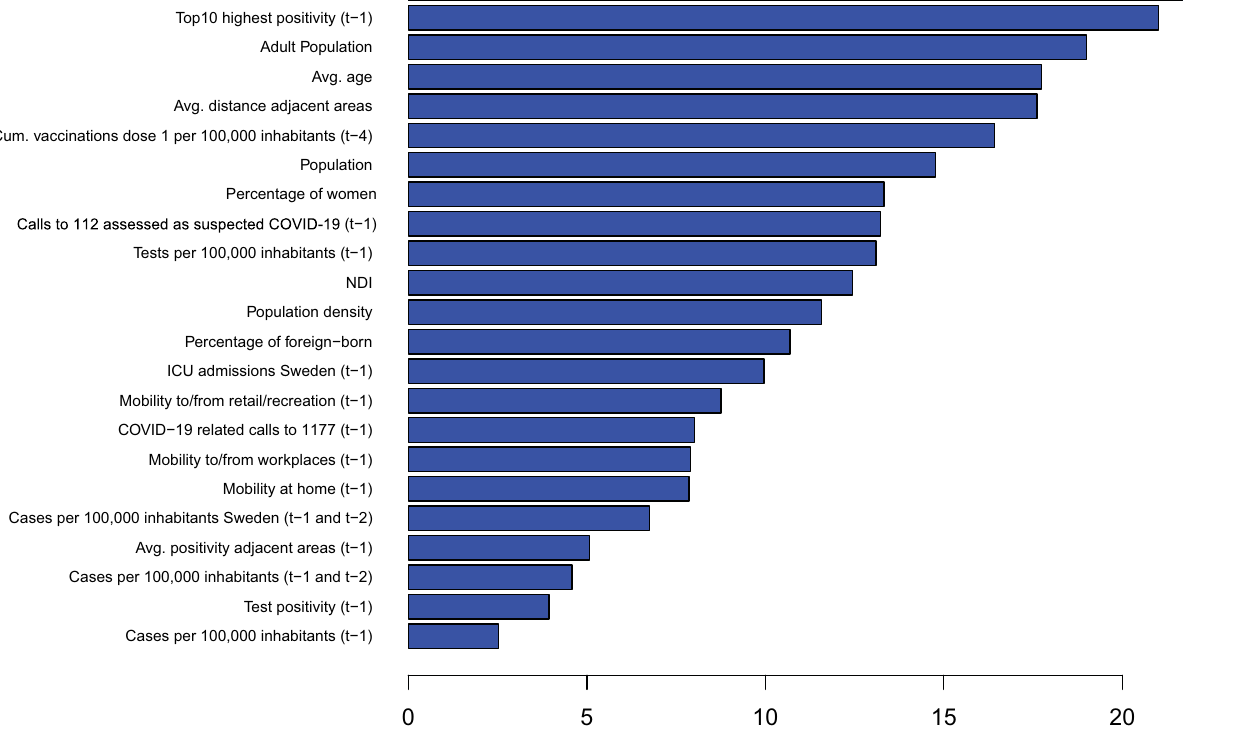
Figure 1. Gradient boosting, averaged ranking (over time) of importance for each variable. Lower ranks indicate higher